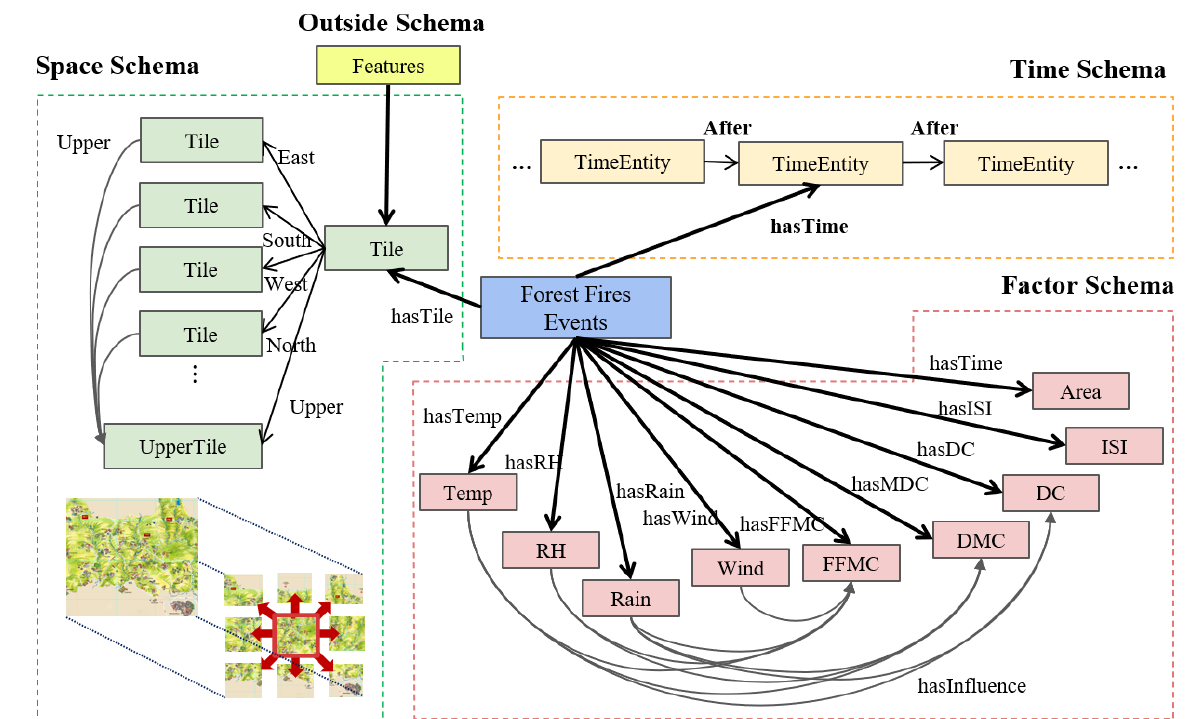
Figure 3. Schema (or concept layer) of the forest fire knowledge graph. The schema is built around forest fire events (in blue). The Space Schema is represented by the green part. The spatial basic unit of forest fire events is represented by rectangular tiles. The tiles have azimuth relations. One upper tile can be divided into 9 smaller tiles. The Space Schema is represented by the yellow part. It regards each temporal entity as a node and organizes it sequentially. The Factor Schema is represented by the red part and contains some common attributes. For future expansion, we reserve Outside Schema for knowledge fusion consideration.